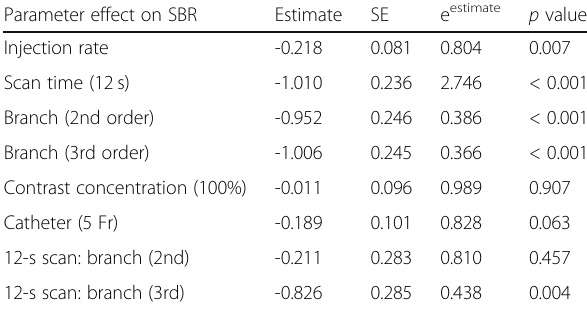
Table 3 Linear mixed model summary for sideband ratio